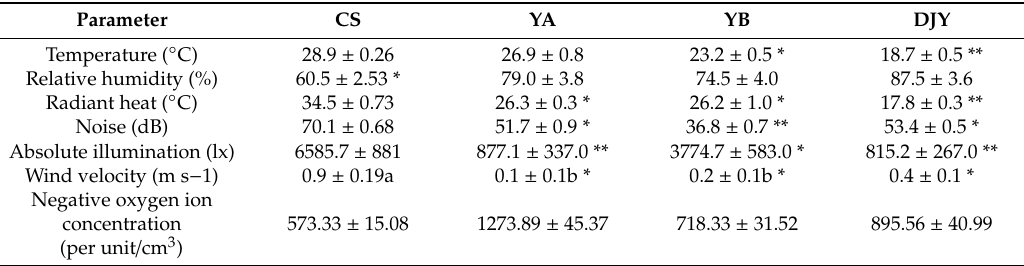
Table 2. Comparison of the environmental factors of the four environmental